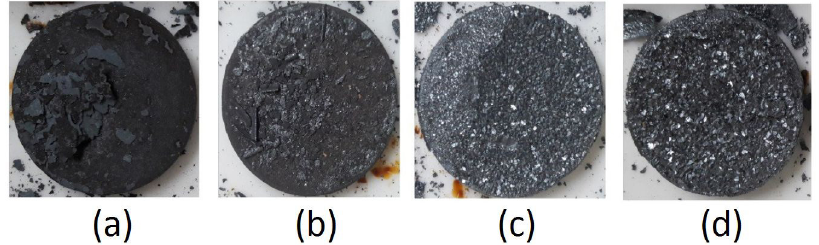
Figure 6. Photos of AISI 304L samples surfaces after 1.5 h of oxidation in water at (a) 1100 °C, (b) 1200 °C, (c) 1300 °C, and (d) 1350 °C.